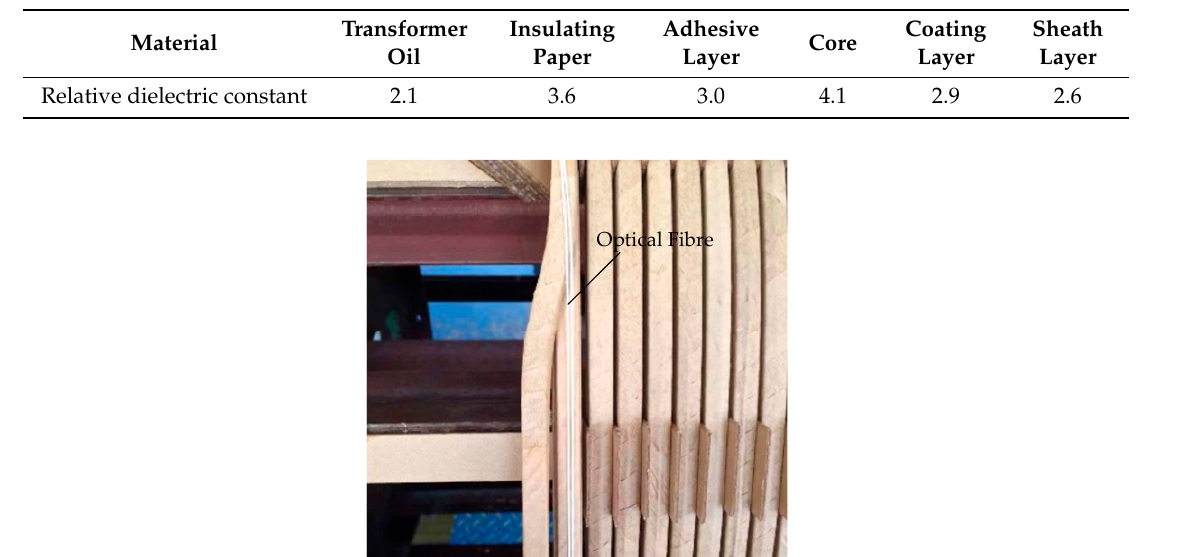
Table 2. Model parameters for electrical field simulation.